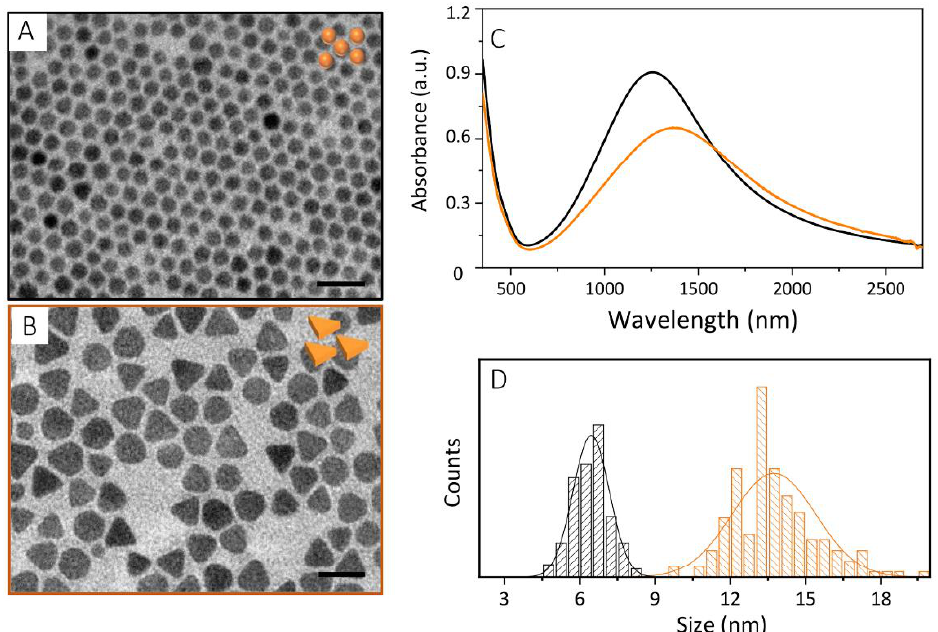
Figure 1. TEM micrographs (( A , B ), scale bar 20 nm) and UV-Vis-NIR absorption spectra ( C ) of Cu 2 − x S nanocrystals synthesized by the hot-injection approach using CuCl (A, black line C) and CuCl 2 (( B ), orange line ( C )) precursors. Panel ( D ), diameter (black bar) and edge-length (orange bar) distribution of Cu 2 − x S nanocrystals as measured by statistical analysis of TEM micrographs reported in panel A and in B, respectively.